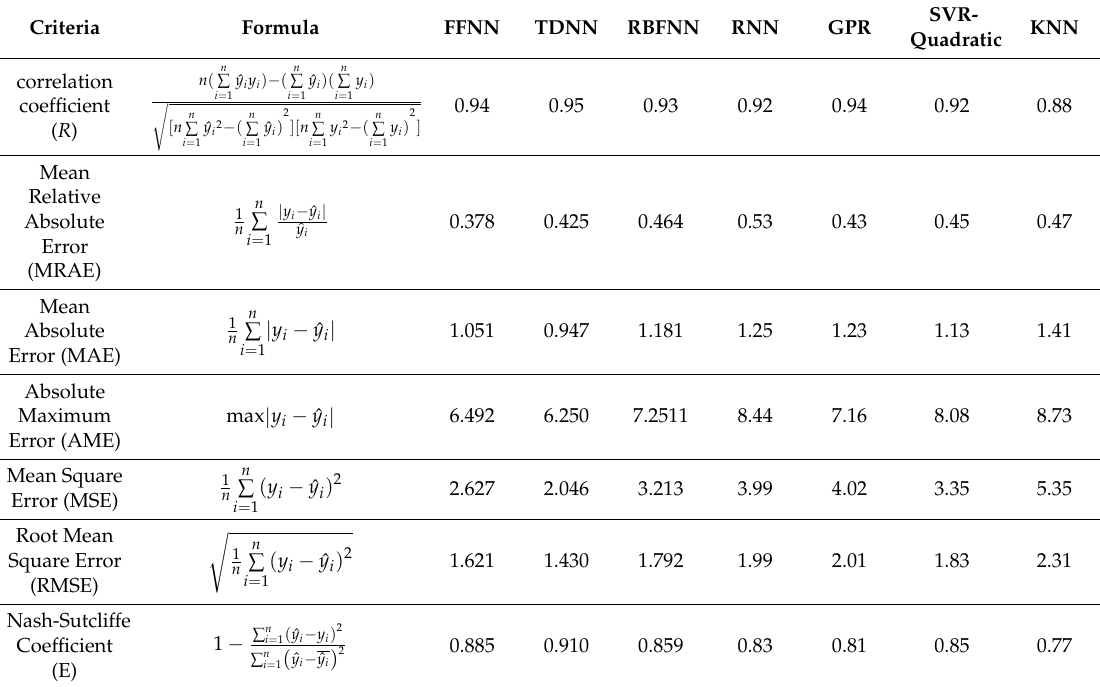
Table 2. Residual criteria for the results of training data for Alavian Basin, where n is the number of observations, y i and ˆ y i are the simulated and observed data, respectively, and ˆ y i is the average observed data.